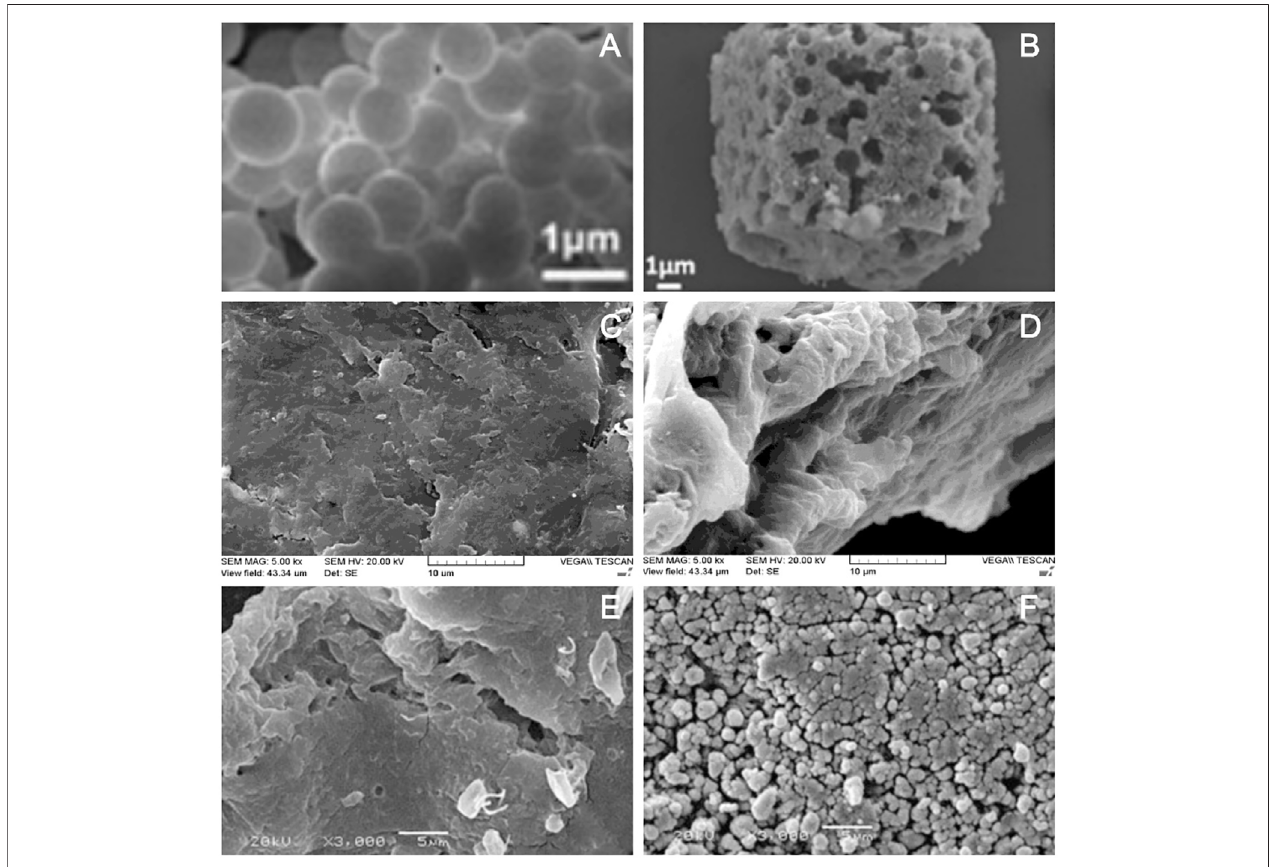
FIGURE 7 | SEM images of carbon sphere (A) and DP Mn 2 O 3 -carbon-PVP cubes (B) (Shao et al., 2017); CTS (C) and TCCTS (D) (Dai et al., 2012); NSC (E) and crosslinked NSC resin (F) (Sun et al., 2007).